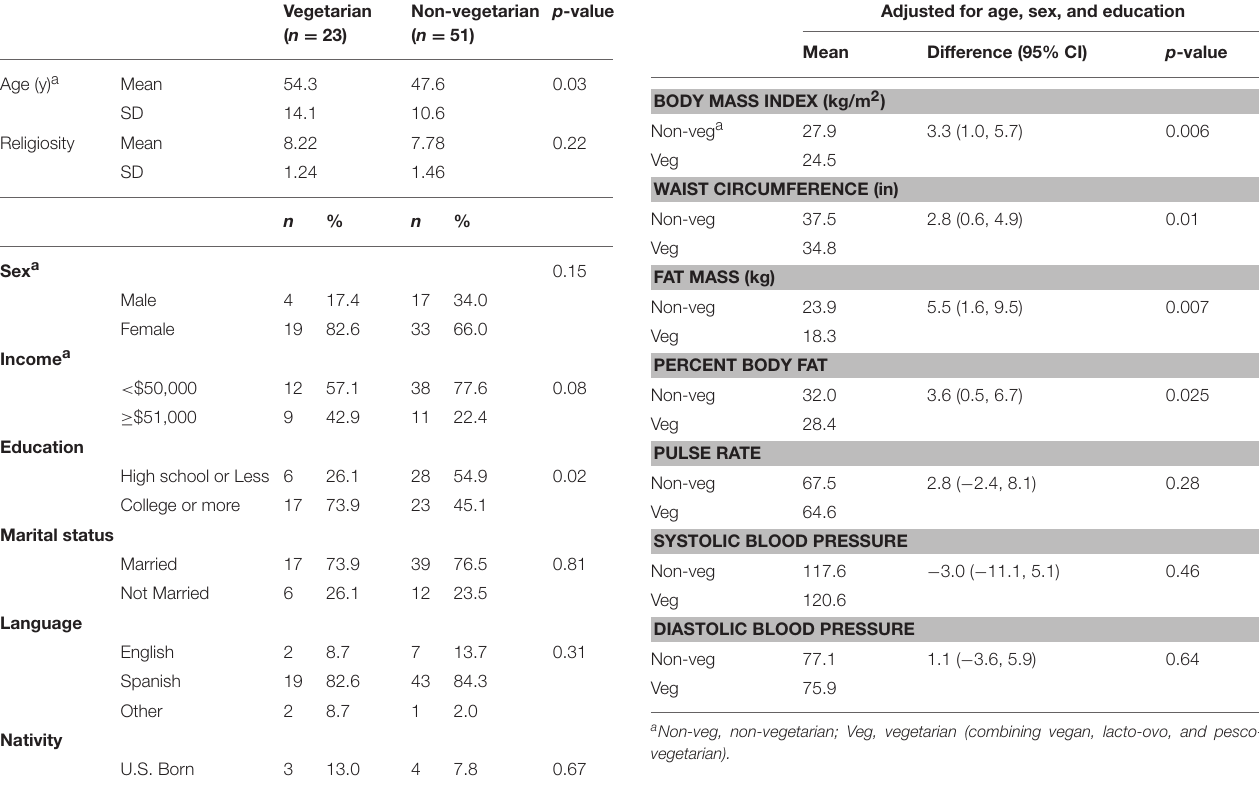
TABLE 2 | Comparison of obesity measures, body composition, pulse, and blood TABLE 1 | Selected characteristics among Hispanic/Latino vegetarians and pressure in vegetarians and non-vegetarians in the AMEN Study. non-vegetarians in the Adventist Multi-ethnic Nutrition (AMEN) Study. p -value Vegetarian Non-vegetarian Adjusted for age, sex, and education ( n = 23) ( n = 51) Mean Difference (95%